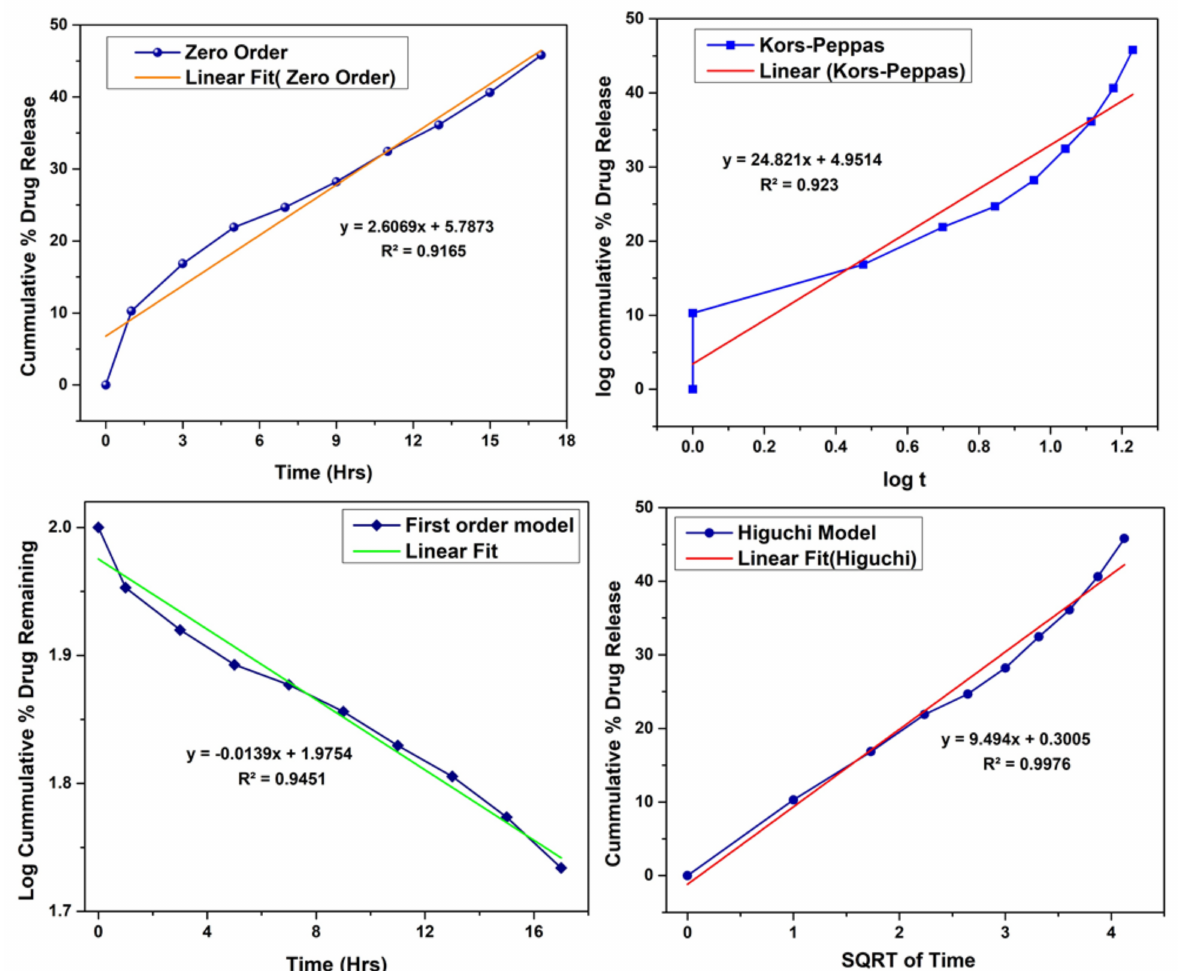
Figure 7. Drug release model